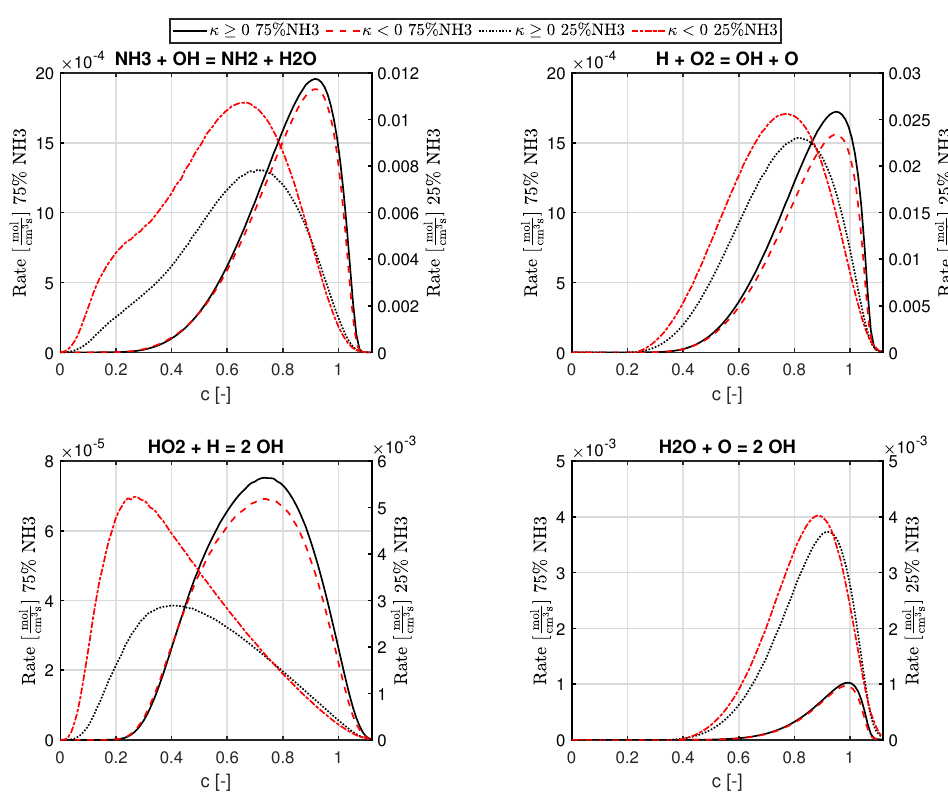
Figure 8. Reaction rates of key reactions involving the consumption of NH 3 and production of OH radicals at a constant equivalence ratio of 0.8 for 75% and 25% NH 3 . The y-axis for the 25% case is on the